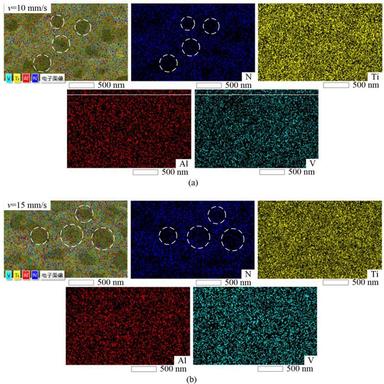
SEM morphologies and the corresponding EDS element mappings obtained under various scanning speeds (P = 1.48 W, r = 76.6 %, f = 700 kHz): (a) 10 mm/s and (b) 15 mm/s.